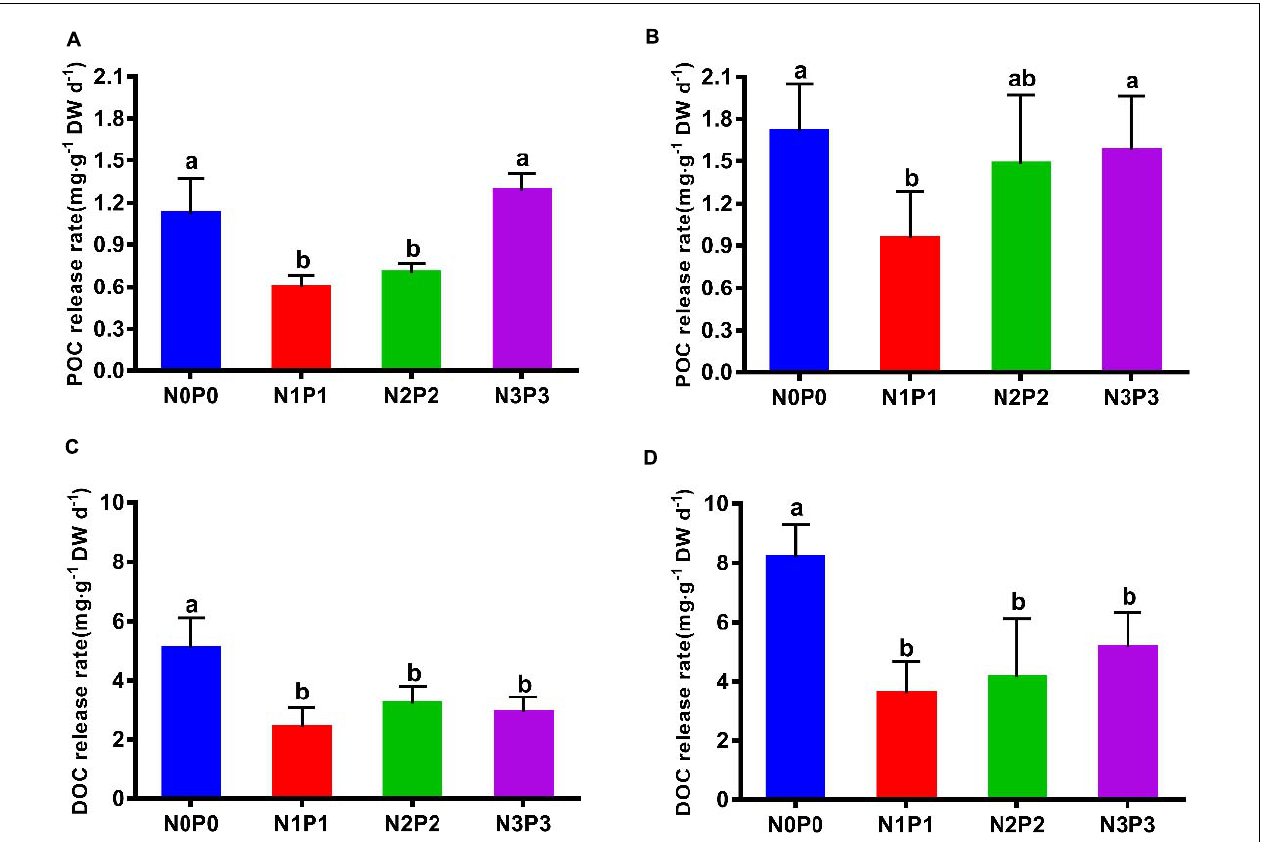
FIGURE 6 | The release rates (mg g − 1 d − 1 DW) of particulate organic carbon (POC) from Z-61 (A) and Z-26 (B) during 15-day incubation. The release rates of dissolved organic carbon (DOC) from Z-61 (C) and Z-26 (D) during 15-day incubation. All data are expressed as mean ± SD ( n = 4). Different letters represent significant differences ( P < 0.05) among the treatments.